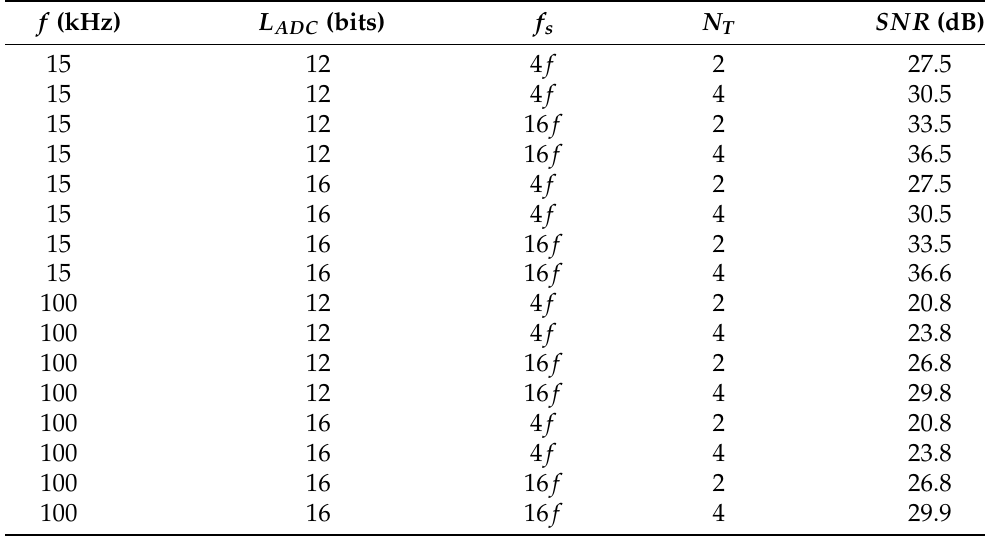
Table 3. Calculated mean SNR values (dB) for each measuring parameter case, according to (19). f